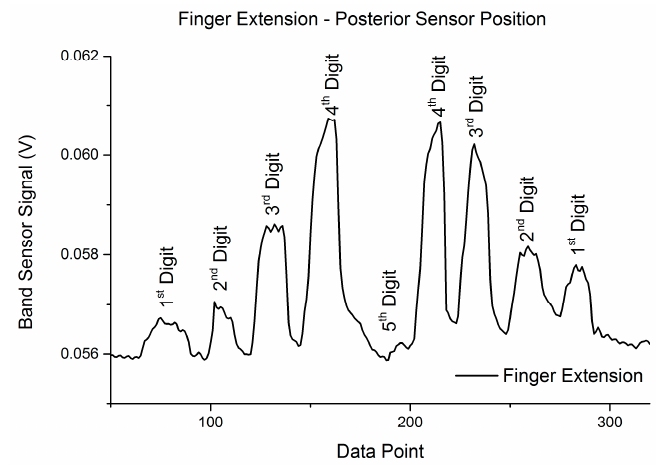
Figure 14. Finger extension motion capture test, sensor in the P1 (posterior) position on the wrist, covering the tendons of the extensor digitorum and digiti